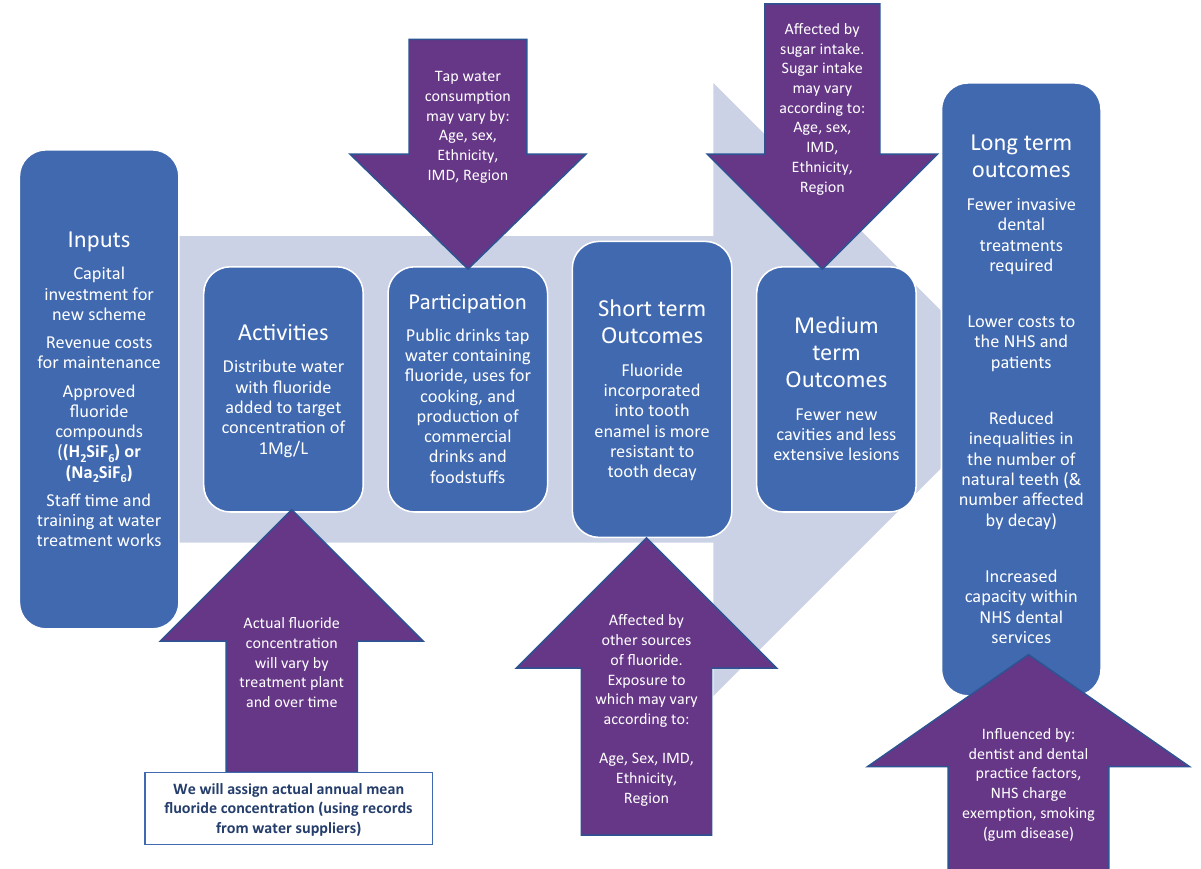
Fig. 1 Logic model for water fl uoridation. A ‘ theory of change ’ illustrating how programme inputs create public health outcomes (columns) and the factors that may in fl uence this process